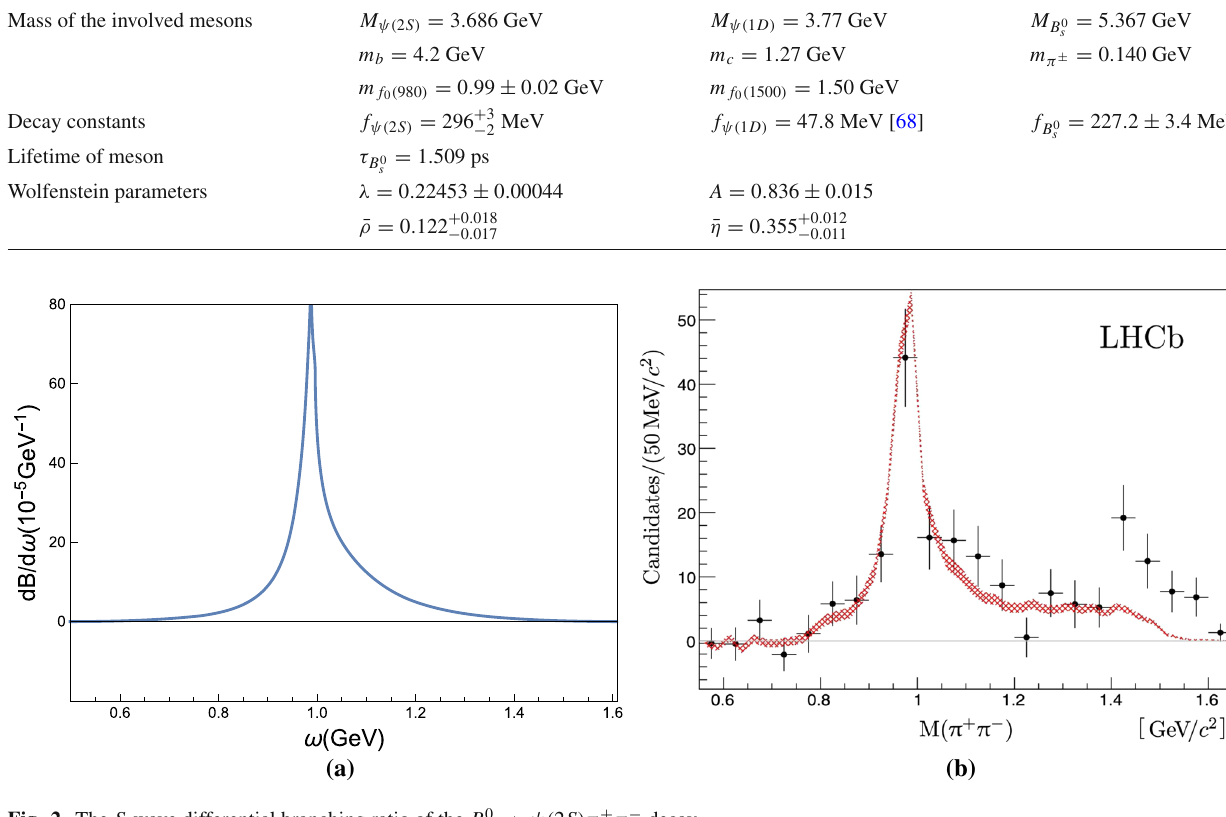
Fig. 2 The S -wave differential branching ratio of the B 0 s → ψ( 2 S )π + π − decay